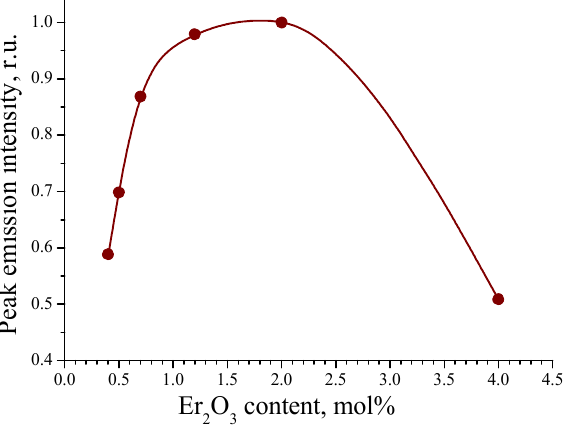
Figure 8. The 1.53 µm luminescence peak intensity as a function of Er 2 O 3 content. The experimental normalized luminescence spectra and the luminescence peak in- tensity dependence on the Er 2 O 3 content for the Er 3+ band near 2.75 µm for TWBL-xEr series glasses are presented in Figures 9 and 10, respectively. The luminescence intensity and bandwidth increase non-linearly with an increase in the doping level; there is no sat-